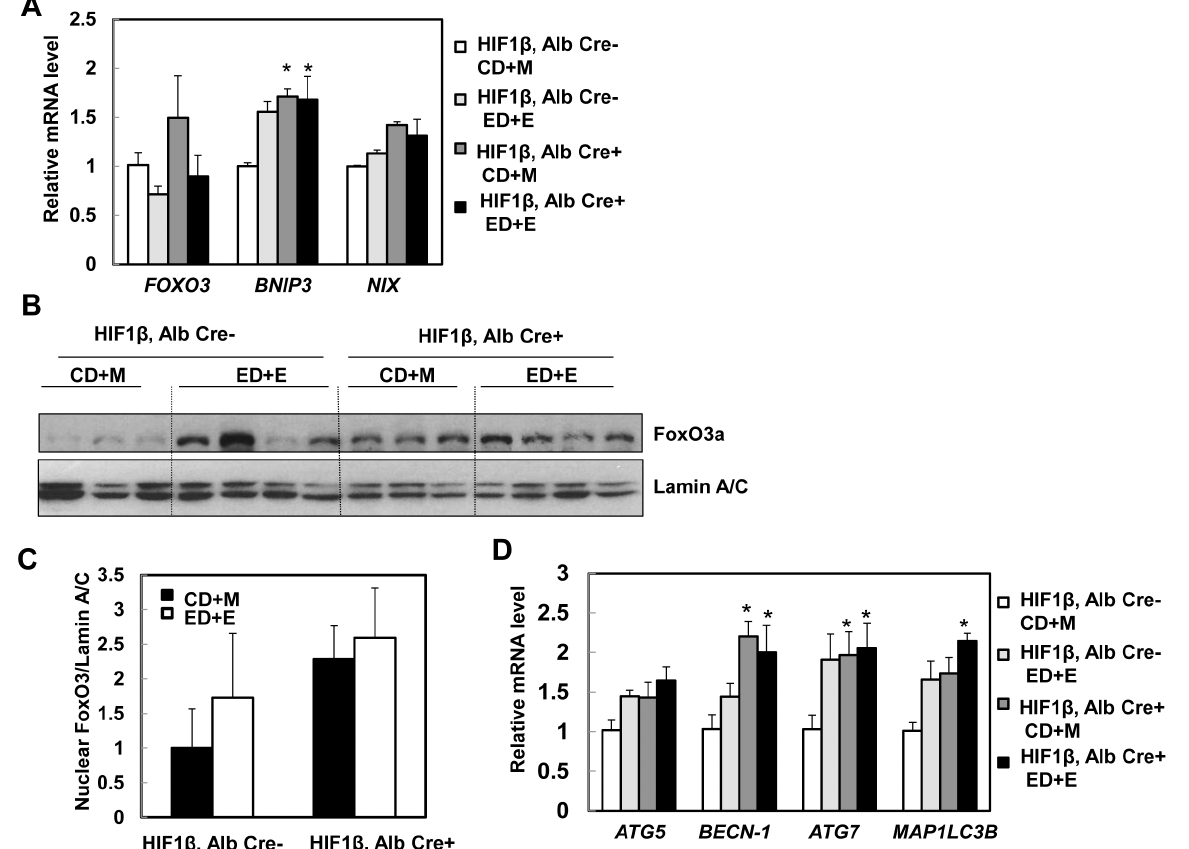
Fig. 7. Changes of FoxO3a in hepatocyte-specific HIF-1 b knockout mouse livers. Matched male wild type and hepatocyte-specific HIF-1 b knockout mice were subjected to Gao-binge treatment. Hepatic mRNA was isolated, and real-time RT-PCR was performed as described in the Materials and Methods to quantify the expression of FOXO3 , BNIP3 and NIX ( A ). Data are presented as means ¡ SE (n 5 3–5). * p , 0.05, vs HIF-1 b CD + M group. One way ANOVA with Scheffe´’s post hoc test. Mice were treated as in ( A ), mouse liver nuclear fractions were prepared as described in the Materials and Methods followed by western blot analysis ( B ) and densitometry analysis ( C ). Data are presented as means ¡ SE (n 5 3). ( D ) Mice were treated as in ( A ), hepatic mRNA was isolated, and real-time RT-PCR was performed as described in the Materials and Methods to quantify autophagy-related genes. Data are presented as means ¡ SE (n 5 3–5). * p , 0.05; * p , 0.05, vs HIF-1 b CD + M group. One way ANOVA with Scheffe´’s post hoc